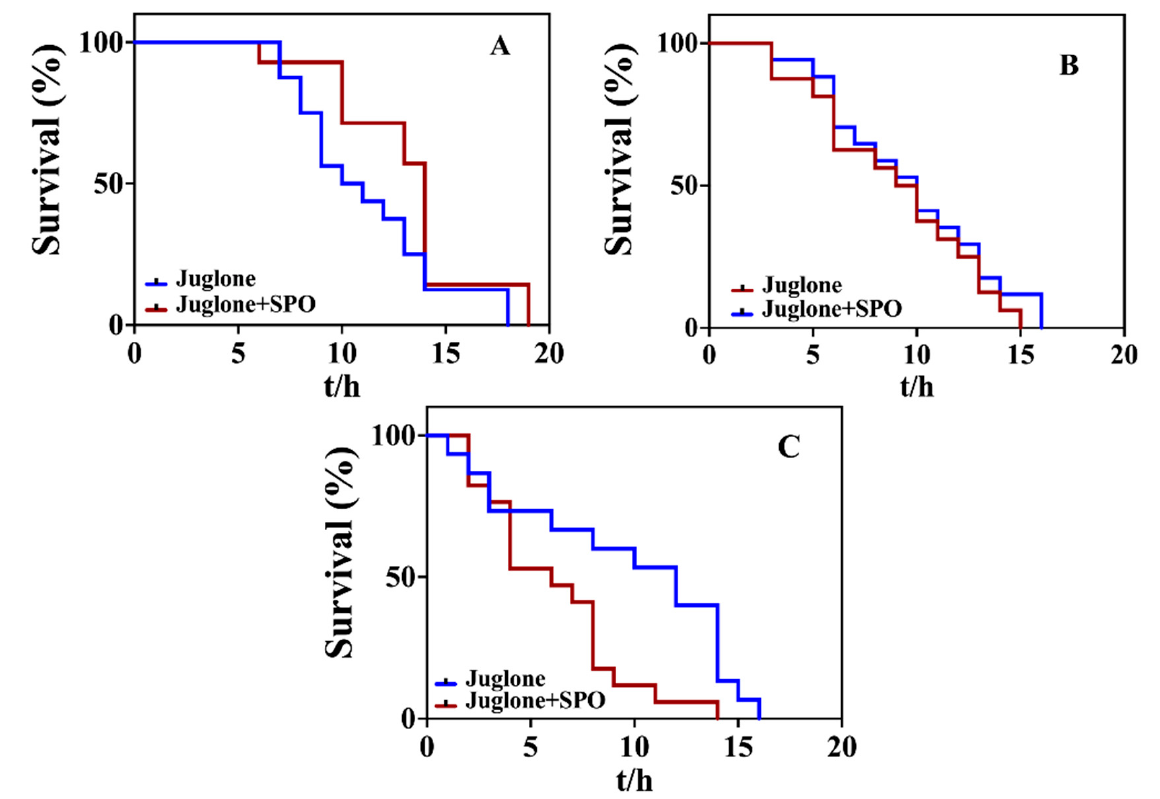
Figure 4. Effect of SPO on the oxidative stress of daf-2 (CB1370) mutant ( A ), sod-3 (GA186) mutant ( B ) and skn-1 (EU31) mutant ( C ) induced with juglone. Table 5. Effect of SPO on the oxidative stress of mutant strain induced with juglone. Mutant Strain Groups Mean Lifespan (h) % of Control Juglone 5.13 ± 0.24 daf-2 (CB1370) Juglone + SPO sod-3 (GA186)